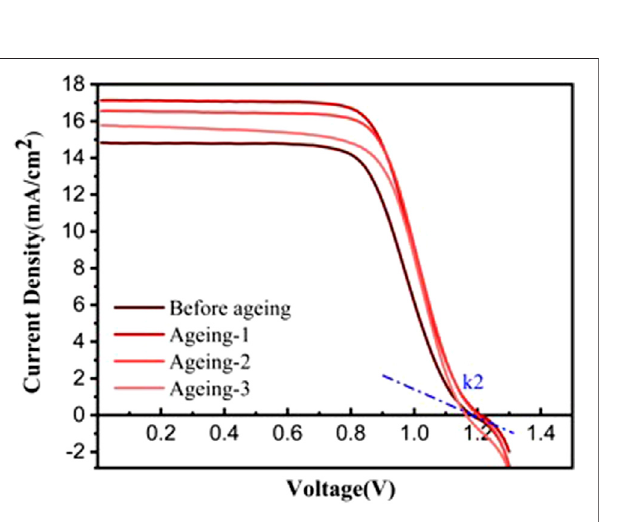
Frontiers in Energy Research |